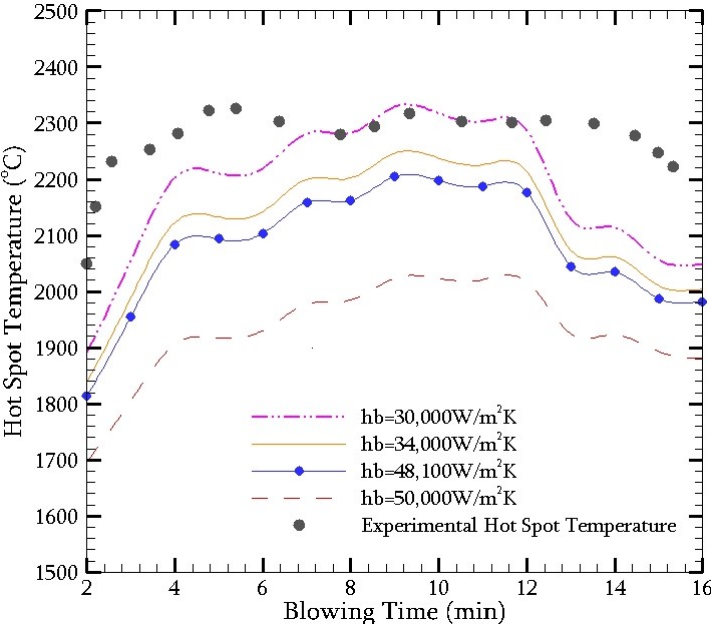
Figure 6. Hot spot temperature profile for different values of heat transfer coefficient.